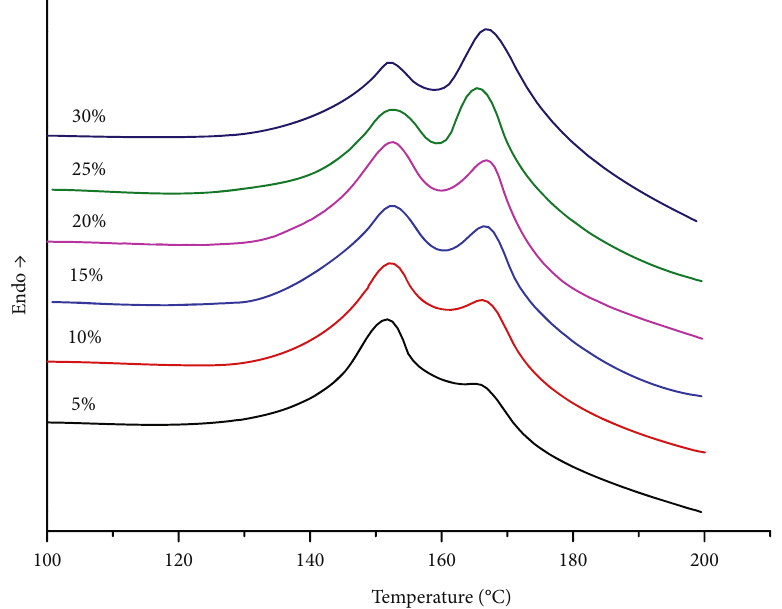
Figure 8: DSC heating curves of PP/WBG/GF-P at di ff erent GF-P wt%